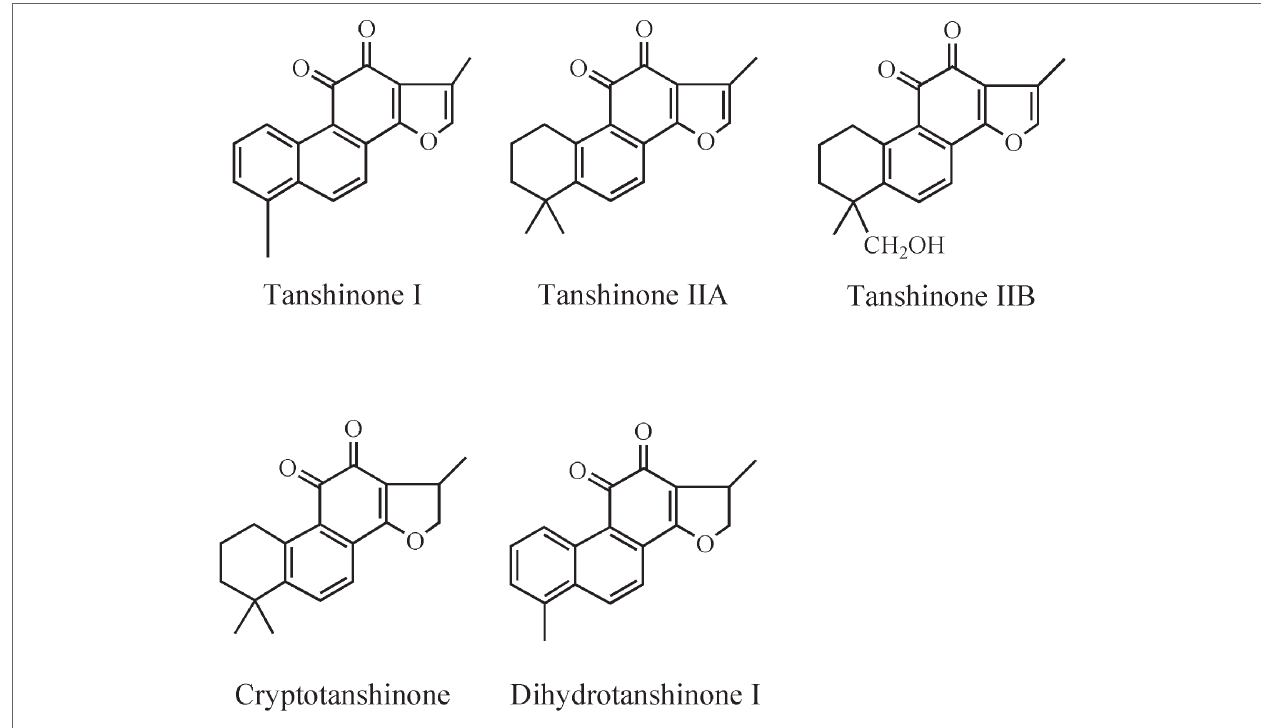
FIGURE 1 | Chemical structures of major